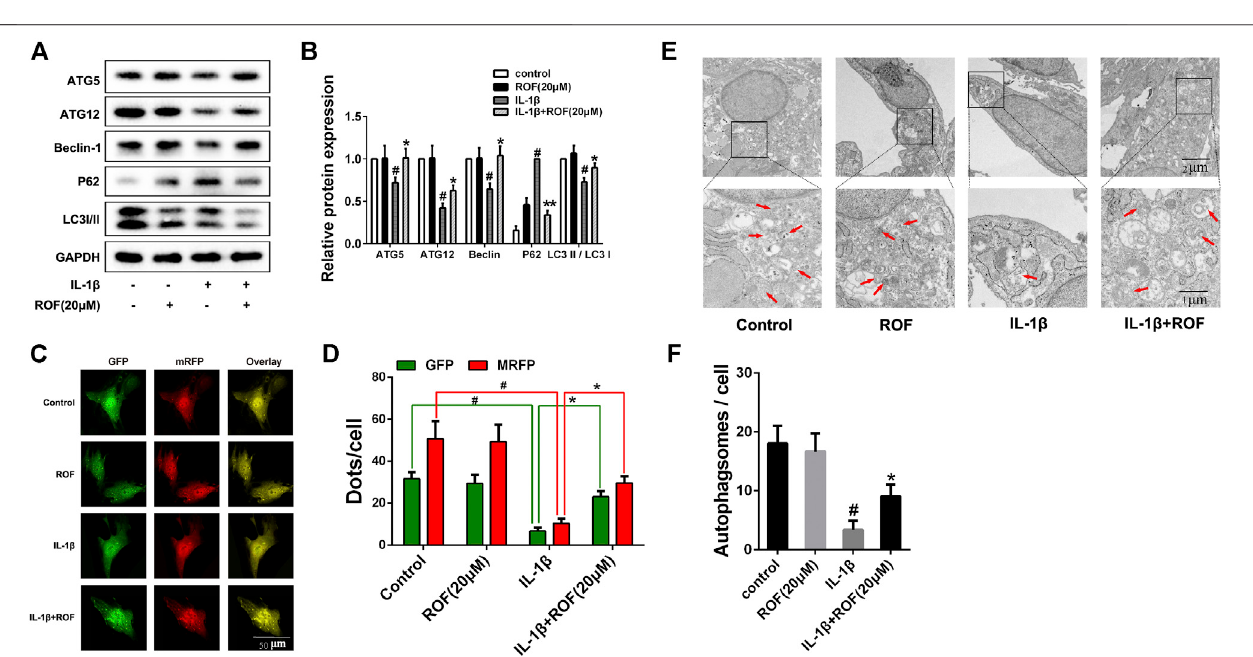
FIGURE 3 | ROF suppresses IL-1 β – induced autophagy downregulation in chondrocytes. (A) Western blots and (B) quantitative analysis of ATG5, ATG12, Beclin- 1, P62-sequestosome and LC3 Ⅱ /LC3 Ⅰ in each group. (C) Fluorescence microscopy and (D) quantitative analysis of cells transfected with tandem GFP-RFP-LC3 adenovirus in each group. (E) TEM images and (F) quantitative analysis of autophagosomes in each group. Red arrow indicated autophagosome. GAPDH was employed as the internal control ( n (cid:2) 3). # p < 0.05 vs. control group; * p < 0.05 vs. IL-1 β group.